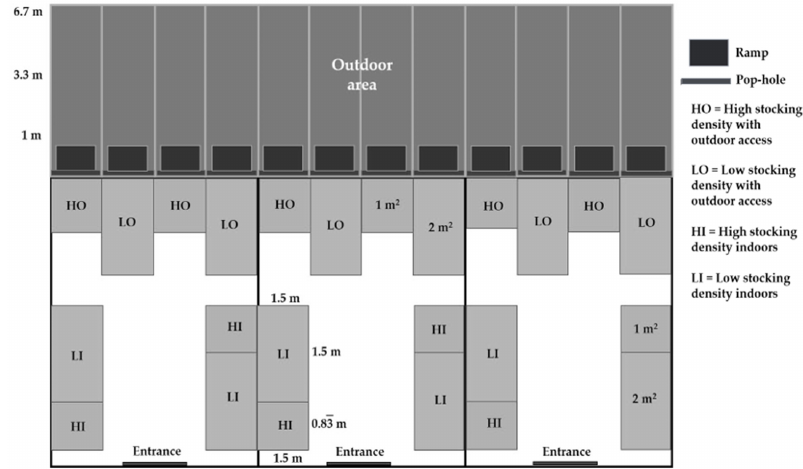
Figure 1. Experimental poultry facilities (from Sanchez-Casanova et al. [14]).